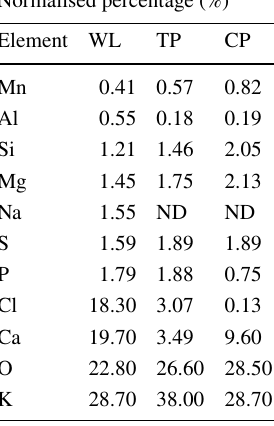
analyses of WL, TP and